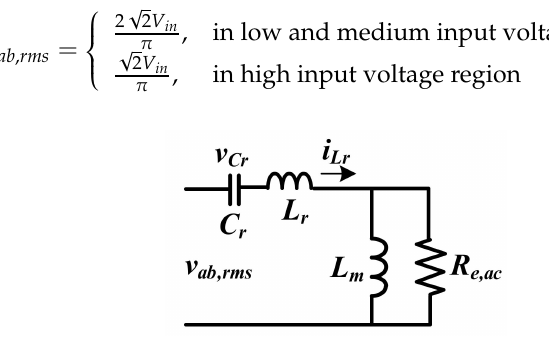
Figure 6. The equivalent resonant circuit on the